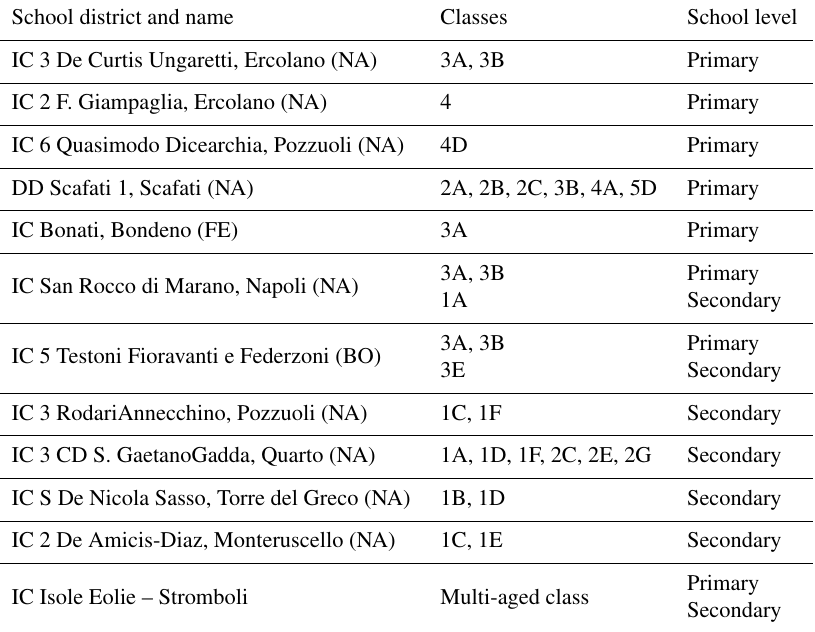
Table 1. List of attending schools. School district and